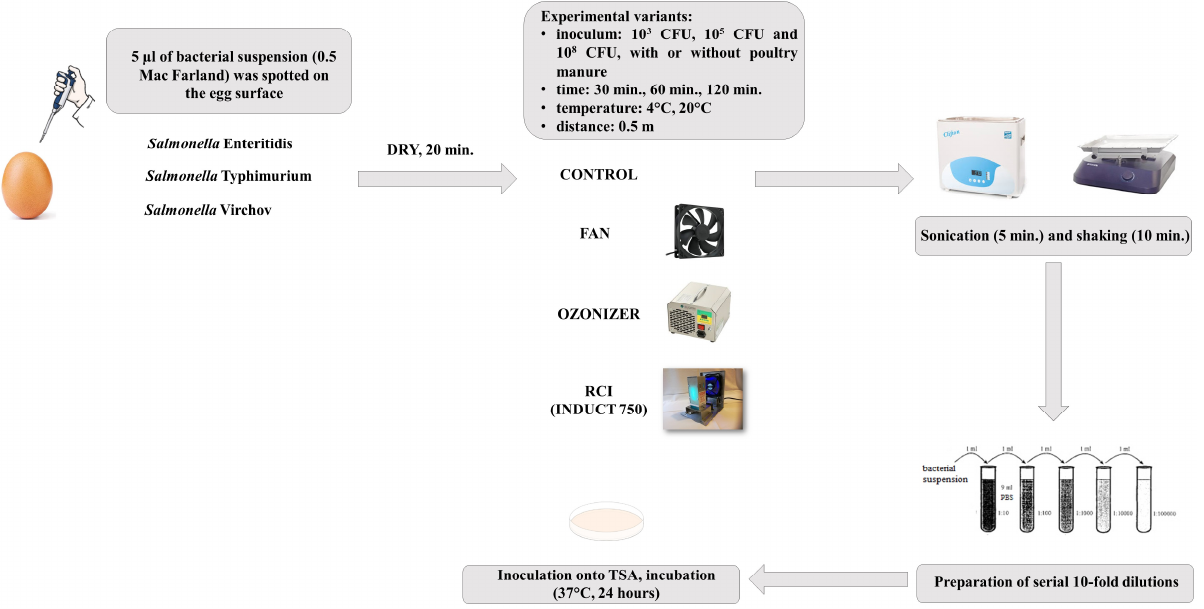
Figure 2. A scheme of experiment